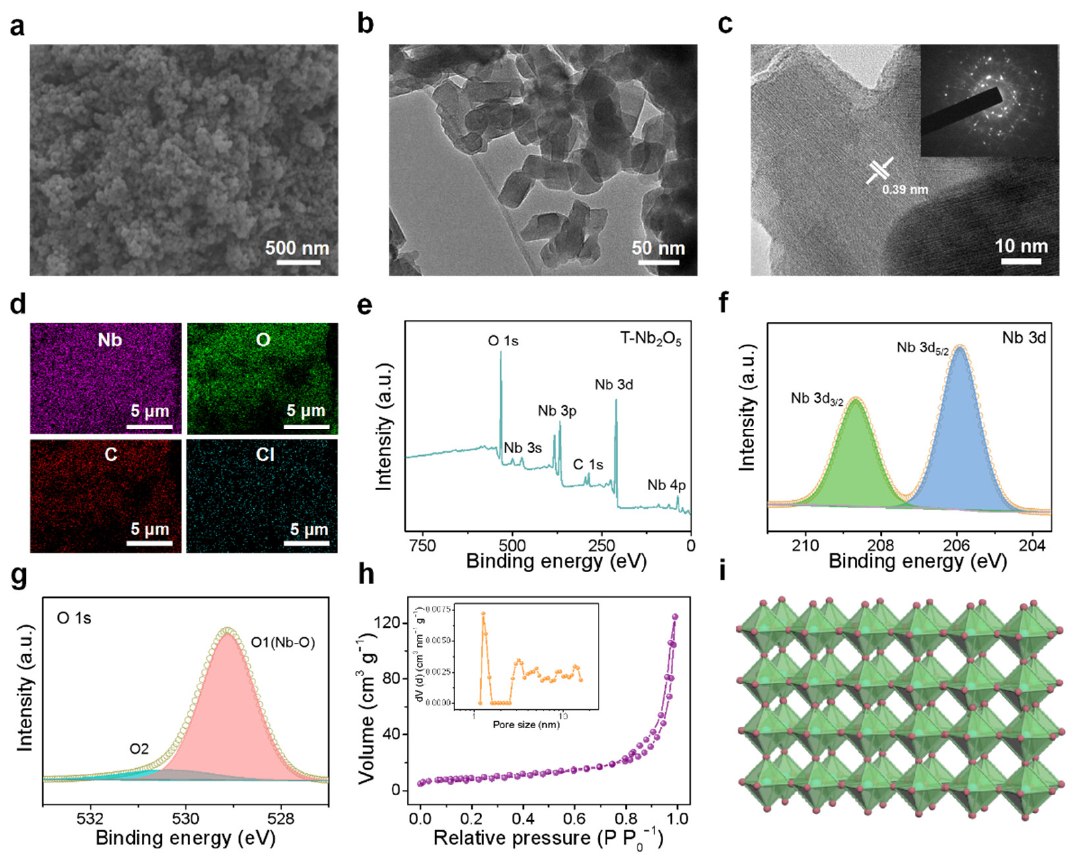
Figure 3. Morphology and physical analysis of T−Nb 2 O 5 . ( a ) Respective SEM image of T−Nb 2 O 5 with abundant nanoparticles. ( b ) Typical TEM image of Nb 2 O 5 with a spherical micro-morphology. ( c ) High-resolution TEM images reflecting the maximum crystal plane spacing. ( d ) Element mapping images of T−Nb 2 O 5 for Nb, O, C, and Cl elements. ( e ) XPS survey of T−Nb 2 O 5 . ( f ) Deconvolution curves of the Nb3d of T−Nb 2 O 5 . ( g ) Deconvolution curves of the O1s of T−Nb 2 O 5 . ( h ) Pore size distribution of T−Nb 2 O 5 . ( i ) Schematic diagram of T−Nb 2 O 5 .